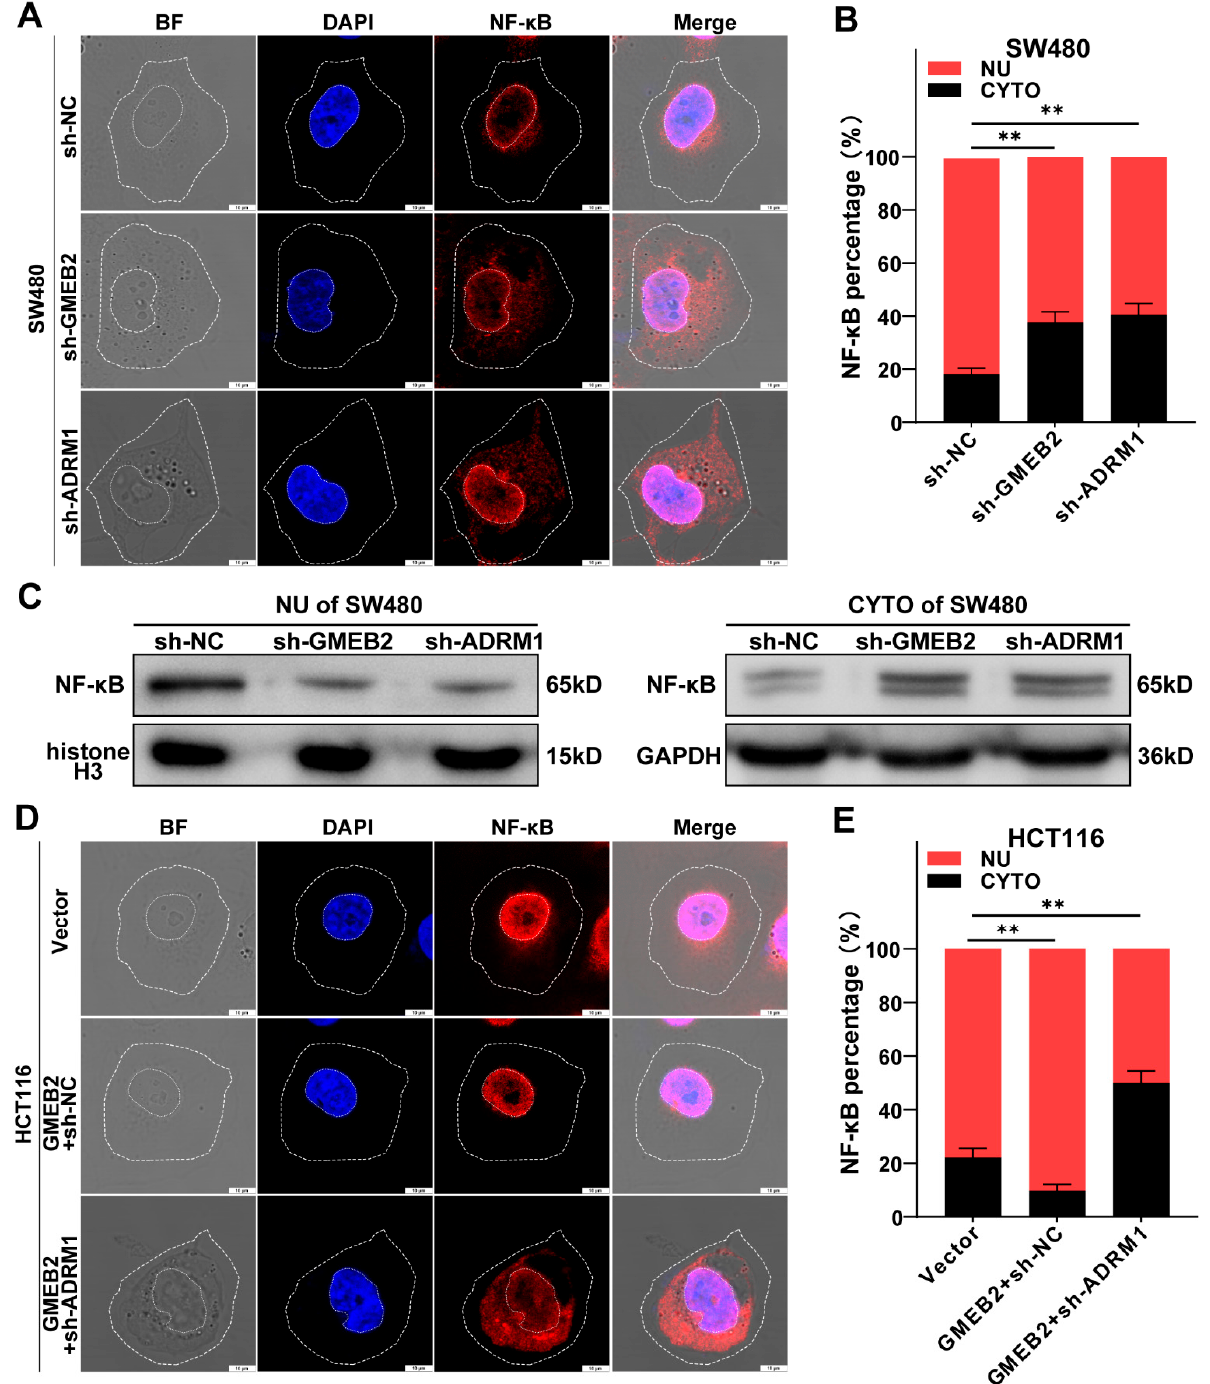
Figure 5. The GMEB2/ADRM1 axis can activate NF- κ B signalling through increasing NF- κ B nuclear translocation. ( A ) The confocal image showed NF- κ B (p65) protein expression and localization in SW480 cells with GMEB2, ADRM1 or scrambled shRNA. ( B ) The proportion of fluorescence in the cytoplasm versus the nucleus was quantified for NF- κ B (Student’s t -test, ** p < 0.01). ( C ) Western blotting showed NF- κ B localization in SW480 cells with GMEB2, ADRM1 or scrambled shRNA, histone-H3 (a nuclear marker) and GAPDH (a cytoplasmic marker) as controls. ( D ) The confocal image showed NF- κ B localization in GMEB2-overexpressing HCT116 cells transfected with the ADRM1-knockdown plasmid. ( E ) The proportion of fluorescence in the cytoplasm versus the nucleus was quantified for NF- κ B (Student’s t -test, ** p < 0.01). Scale bar, 10 µ